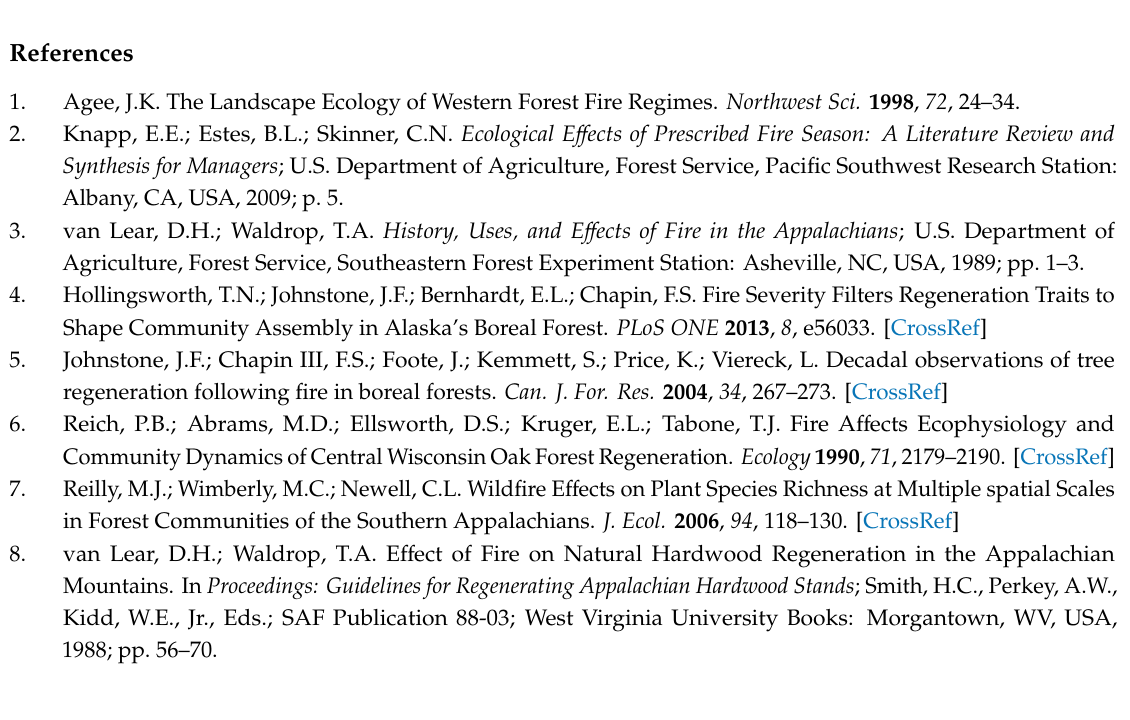
Figure S1: Summary temperature statistics (mean, max, min, range), collected with iButton temperature loggers in 4 experimental burn severity treatments (control, level 1 (low), level 2 (moderate), level 3 (high)) over a 40-day period. There were 4 replicates for each treatment (n = 16). Rainfall events are marked in blue, with total daily rainfall (cm) listed. Results with di ff erent uppercase letters, for a given parameter on a given day, were statistically di ff erent at α =